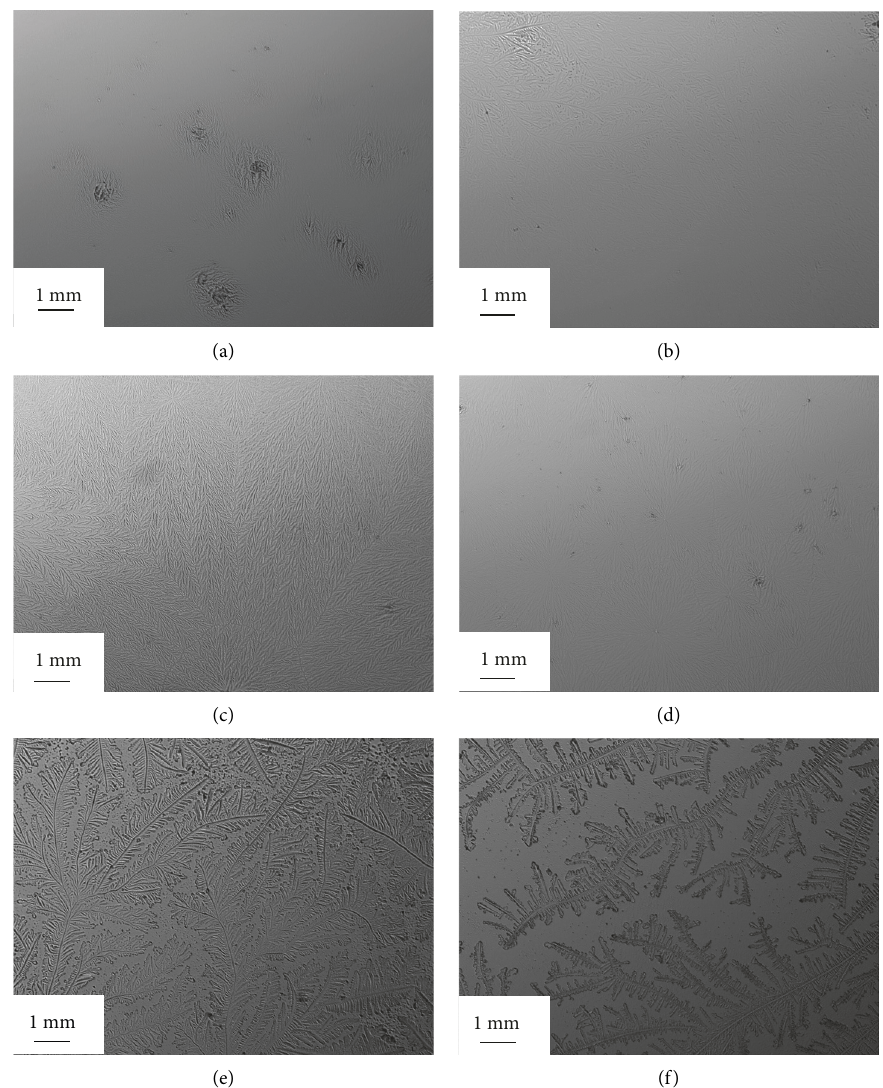
Figure 5: Representative TF images for the tears of three subjects before (a, c, e)and after (b, d, and f) wearing a face